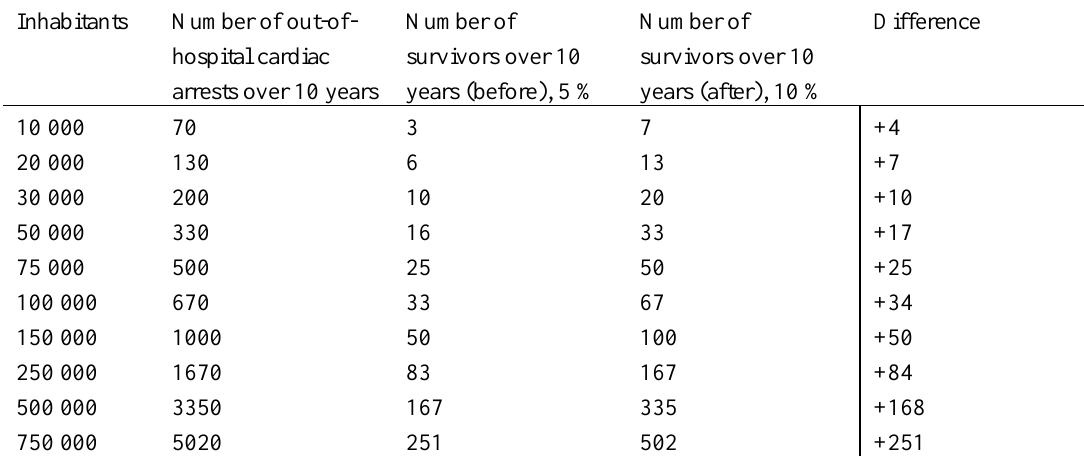
Table A1: The valuation scenario and WTP questions for the contingent valuation